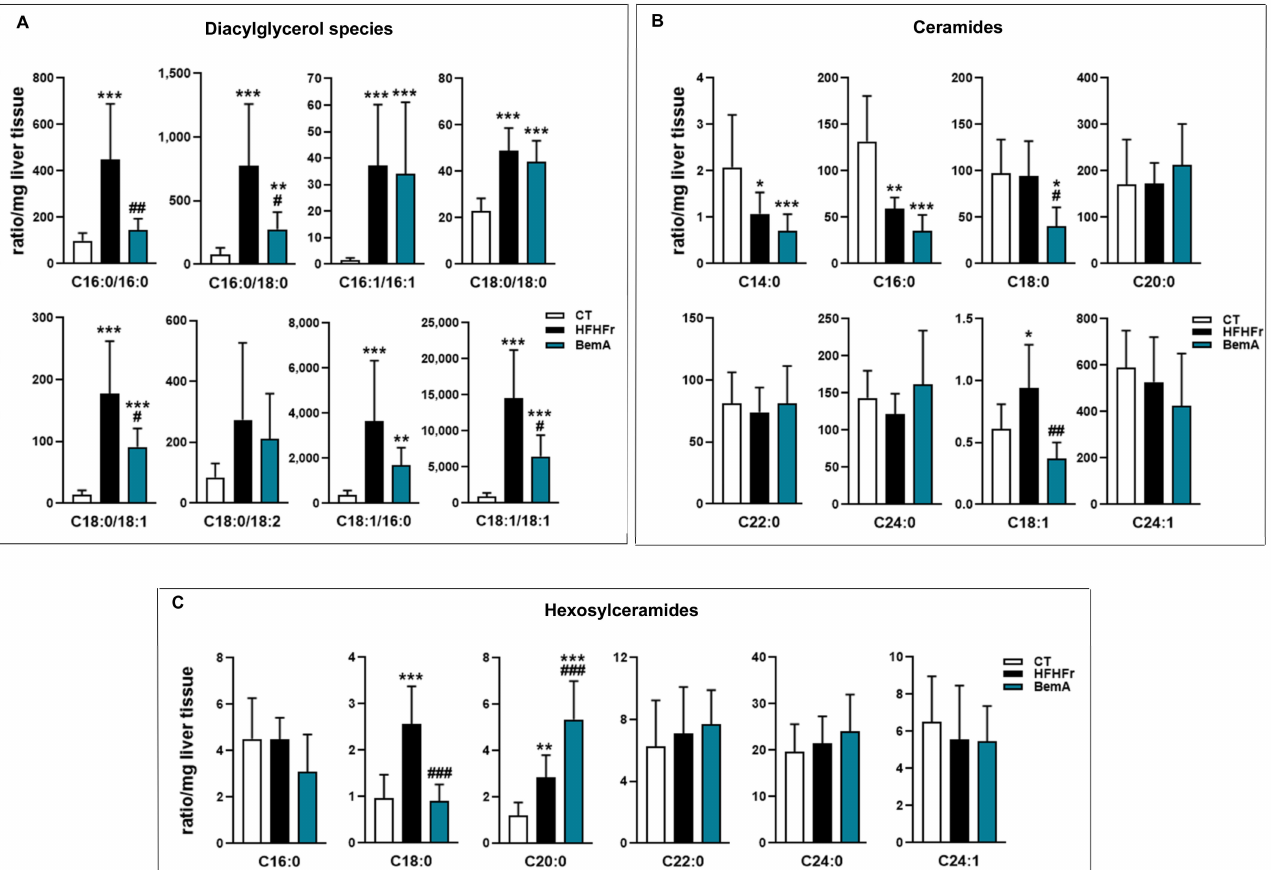
Figure 5. Bempedoic acid modifies the lipidomic signature induced by the HFHFr diet in the liver. Bar plots showing the levels of ( A ) diacylglycerols, ( B ) ceramides, and ( C ) hexosylceramides in rat liver homogenates from control (CT), high-fat, high-fructose (HFHFr), and bempedoic acid (BemA) groups. Data were analyzed by one-way ANOVA, followed by Tukey’s post-hoc * p < 0.05, ** p < 0.01, *** p < 0.001 compared to CT; # p < 0.05, ## p < 0.01 ### p < 0.001 compared to